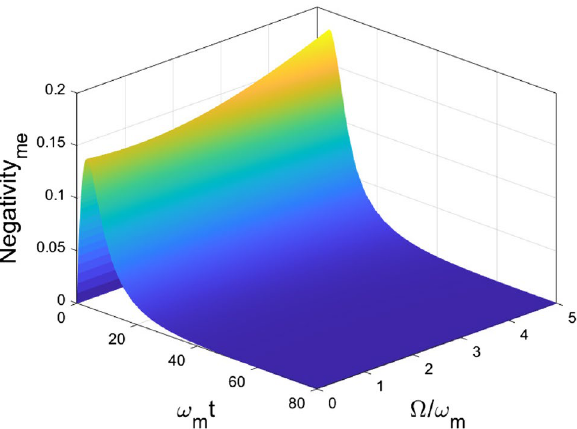
Figure 6. Dynamics of entanglement between ME for different central frequencies of the environment (cid:31) . Other parameters are chosen as ω o = ω e = ω m , g om = g me = 0.1 ω m , Ŵ = 1 .